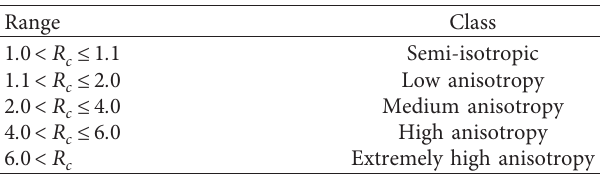
Table 2: Classification of transversely isotropic materials based on the strength anisotropy